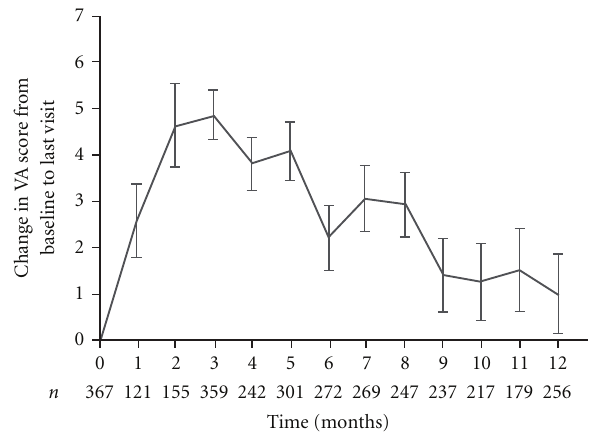
Figure 2: Change in VA score (ETDRS chart) from baseline (BL) to month 12 (on-treatment population, n = 370). Values are shown as mean ±